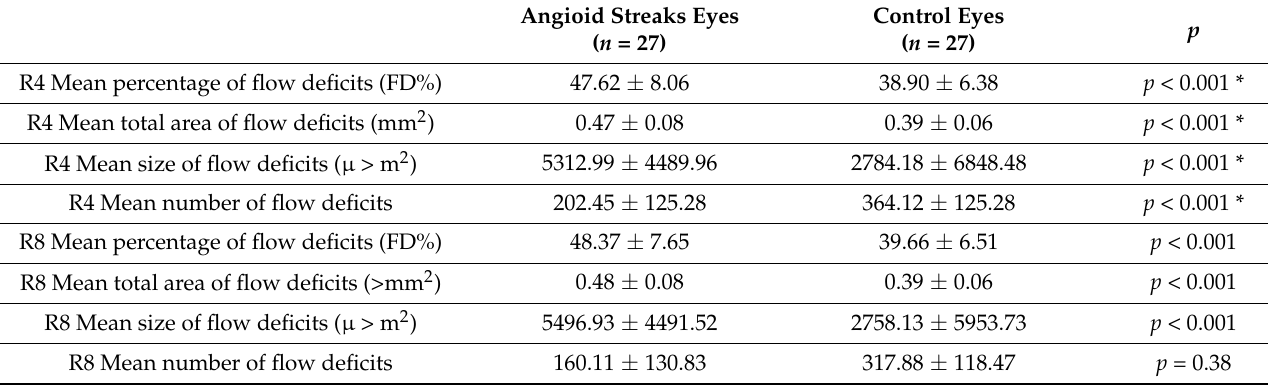
Table 1. Choriocapillaris quantitative study of the peripheral 1 × 1 mm squares applying the Phansalkar local thresholding method: comparisons between angioid streaks eyes and control